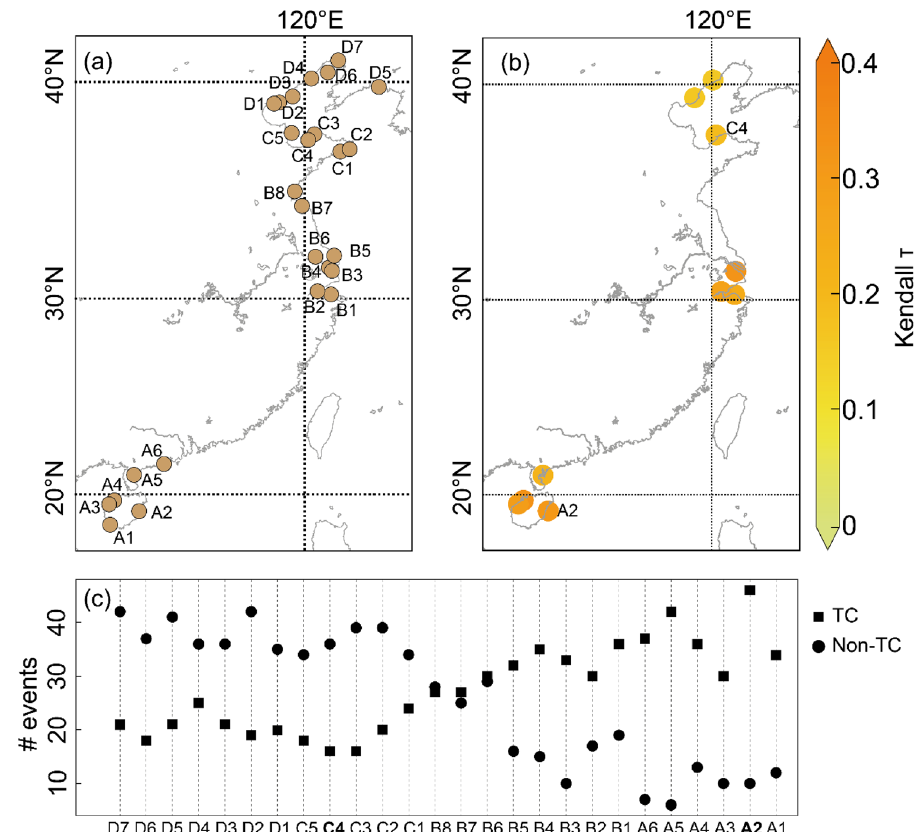
(Fig. 3b). Catchments A2, A3, A4, A5 (south), B1, B2, B3 (center), C4, D3 and D4 (north) show a significant 𝛼 nificance = 0.05). Eastern Hainan Island (catchment A2)